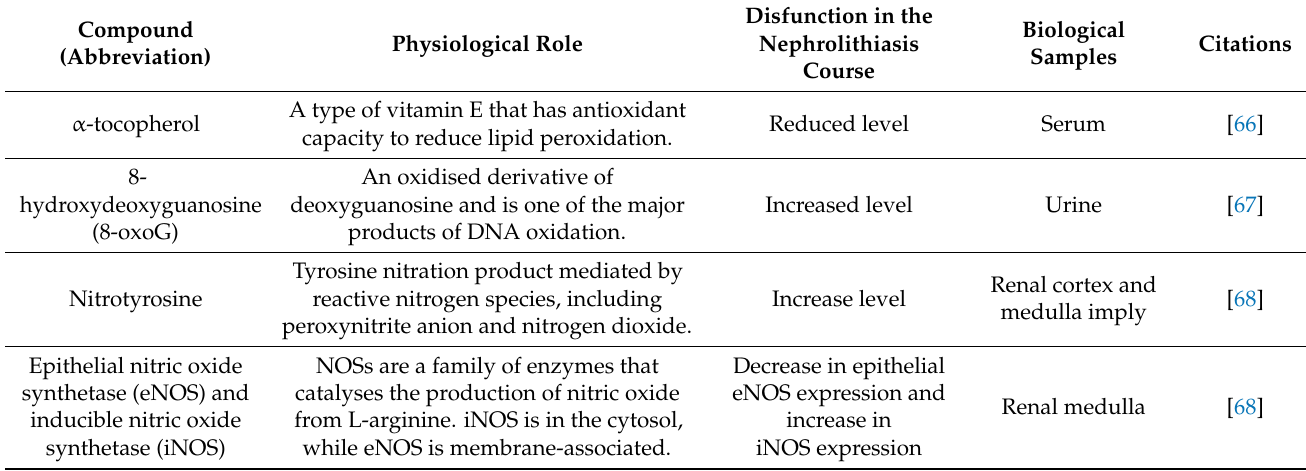
Table 1. Potential biomarkers in kidney stone